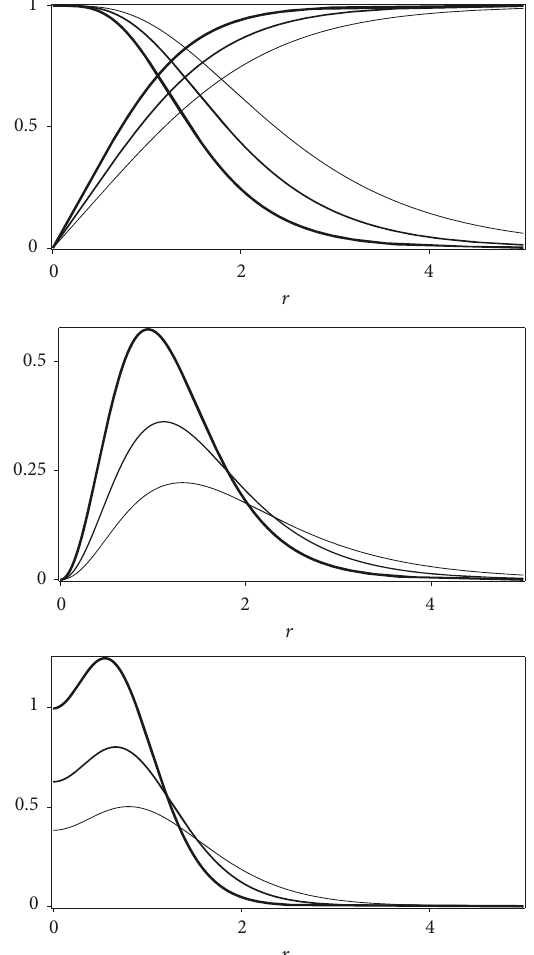
Figure 3: The solutions 𝑎(𝑟) (descending lines) and 𝑔(𝑟) (ascending lines) of (30a) and (30b) (top), the magnetic field (middle), and the energy density (bottom) of the visible sector for 𝑞, 𝑤 = 1 and 𝛽 = 0.5, 1 and 2 . The thickness of the lines increases with 𝛽 .